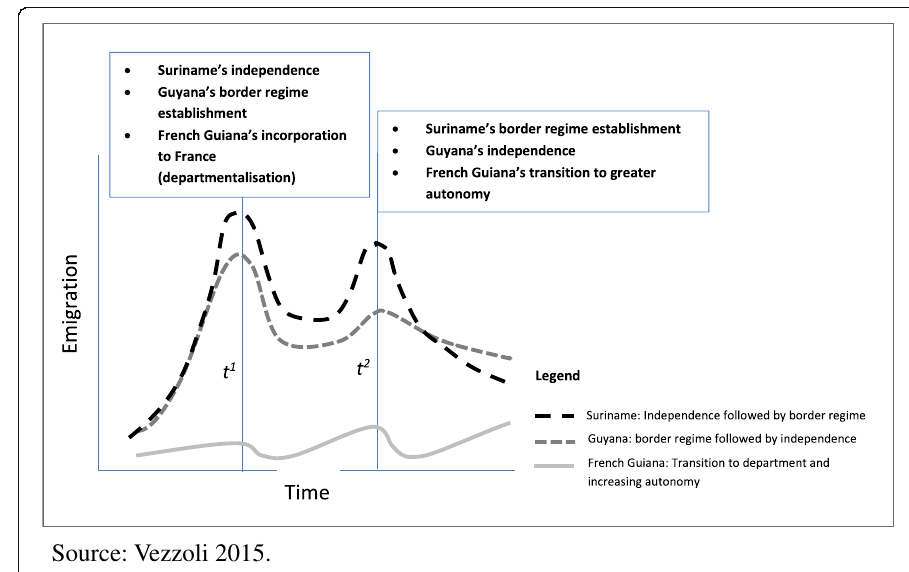
Fig. 10 Schematic representation of migration trends for Guyana, Suriname and French Guiana with respective moments of